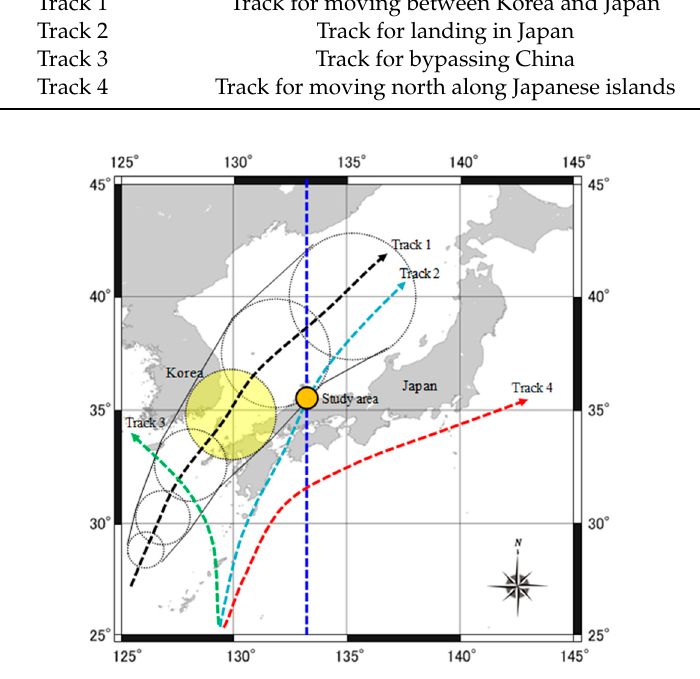
Figure 2. Classification of typhoons by Typhoon track at study area.